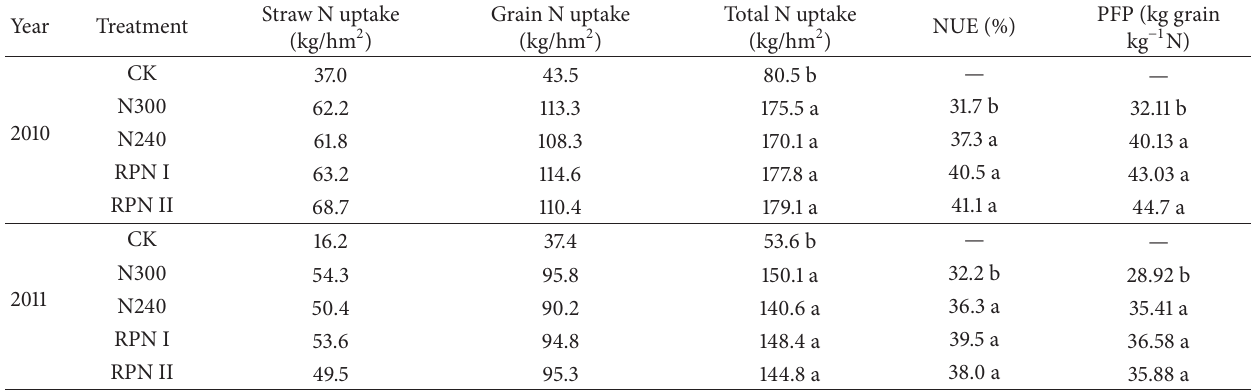
Table 7: Effects of RPN on NUE and